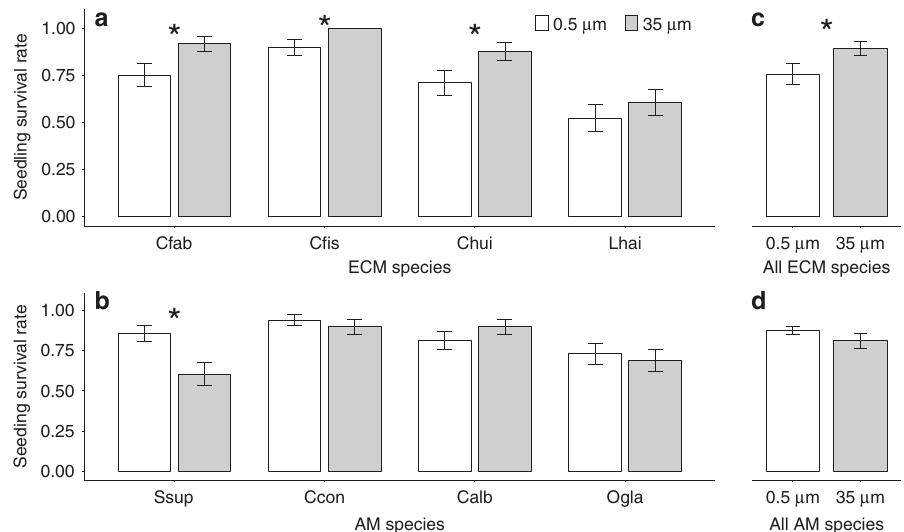
Fig. 2 Effect of mycorrhizal hyphal connections on seedling survival for ECM and AM tree species. Values represent seedling mean survival rates ± s.e.m. for four months after transplanting in the survival experiment. Species studied were: a ECM trees, including Castanopsis fabri (Cfab), Castanopsis fi ssa (C fi s), Cyclobalanopsis hui (Chui), Lithocarpus haipinii (Lhai); b AM tress, including Schima superba (Ssup), Cryptocarya concinna (Ccon), Canarium album (Calb) and Ormosia glaberrima (Ogla). Asterisks indicate signi fi cant differences at P < 0.05 based on one-sided two-proportion z -tests ( n = 48 biologically independent seedlings for each treatment). Source data are provided in a Source data fi